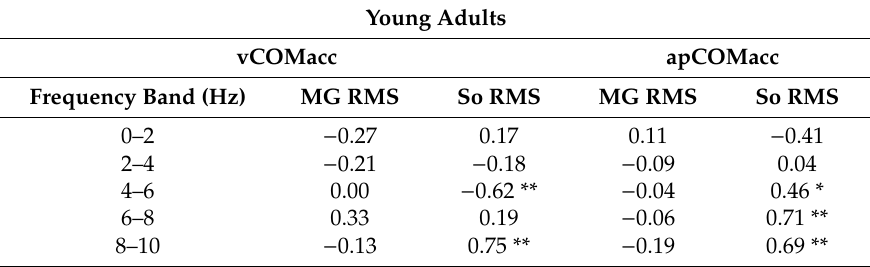
Table 3. Correlation between the power spectral density of vCOMacc or apCOMacc in young adults and the root mean square of lower limb muscle activity.